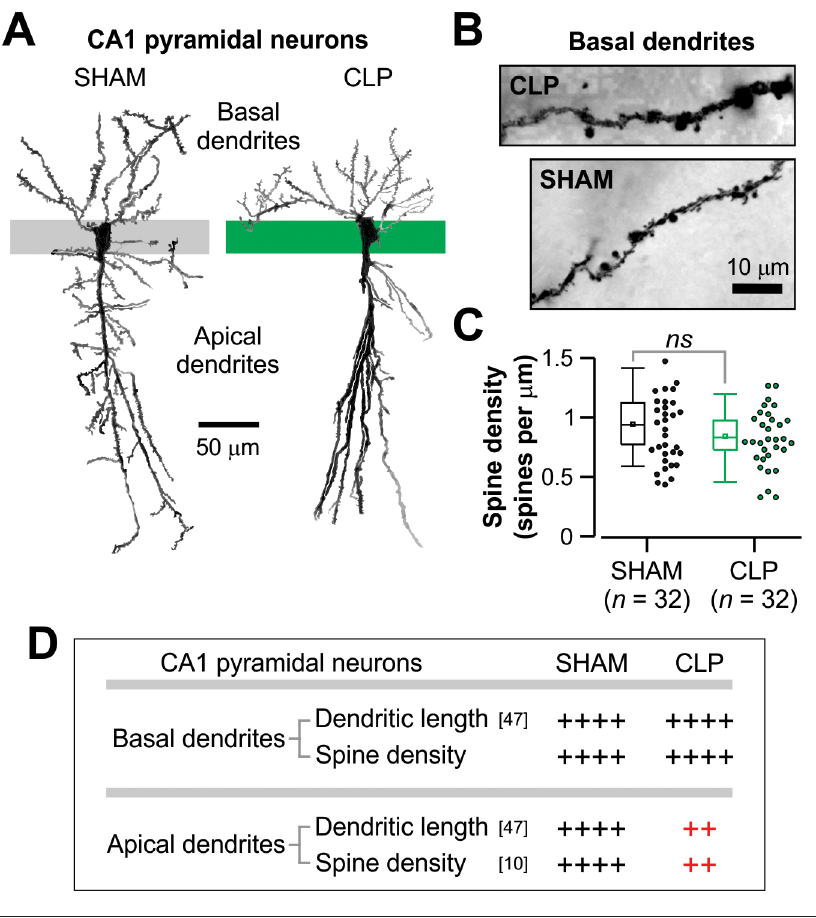
Figure 7. Unaltered basal dendrites in CA1 pyramidal neurons in CLP-exposed mice. (A) Traces of representative Golgi-stained CA1 neurons from the sham and CLP groups. (B) Micrographs show dendritic spines in CA1 basal dendrites. (C) The box plot of spine density in CA1 basal dendrites shows that spine counts are similar between groups; ns, nonsignificant by t test. (D) The table summarizes the data for CA1 pyramidal neurons from this study as well as previous data in references (10) and (47). The basal dendrites are similar between groups in terms of length and spine density, whereas the apical dendrites are disrupted in the CLP